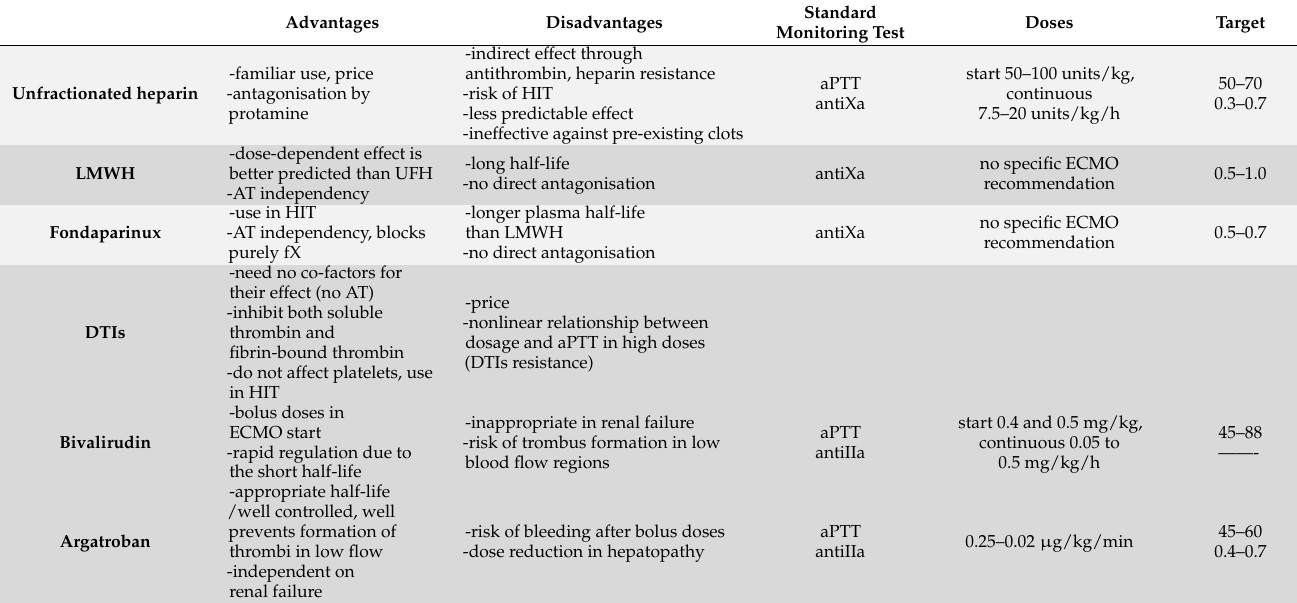
Table 1. Anticoagulants most commonly used in ECMO and their main characteristics. LMWH- low molecular weight heparin;UFH-unfractionated heparin;AT-antithrombin;DTIs-direct